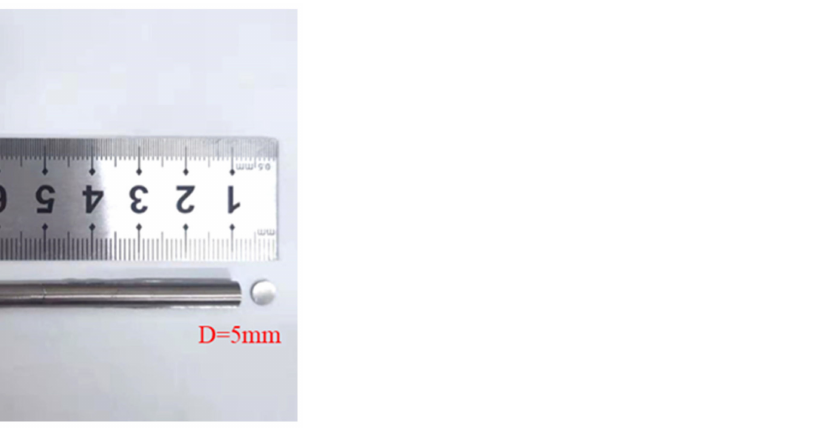
Figure 1. Outer appearance of La 65 Al 14 Ni 5 Co 5 Cu 9.2 Ag 1.8 bulk metallic glass (BMG) rod with a diameter of 5 mm.